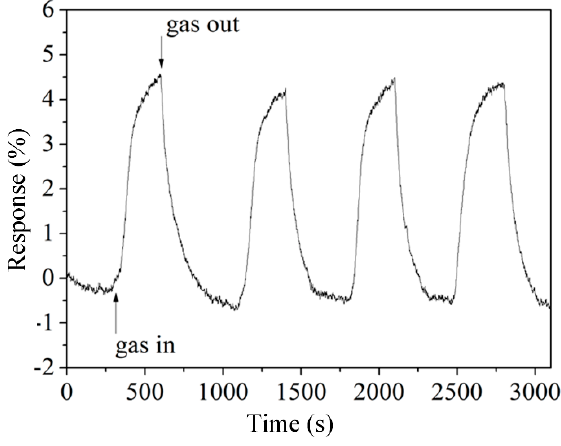
Figure 13. Cycle test for the AGS at 1 ppm ammonia.